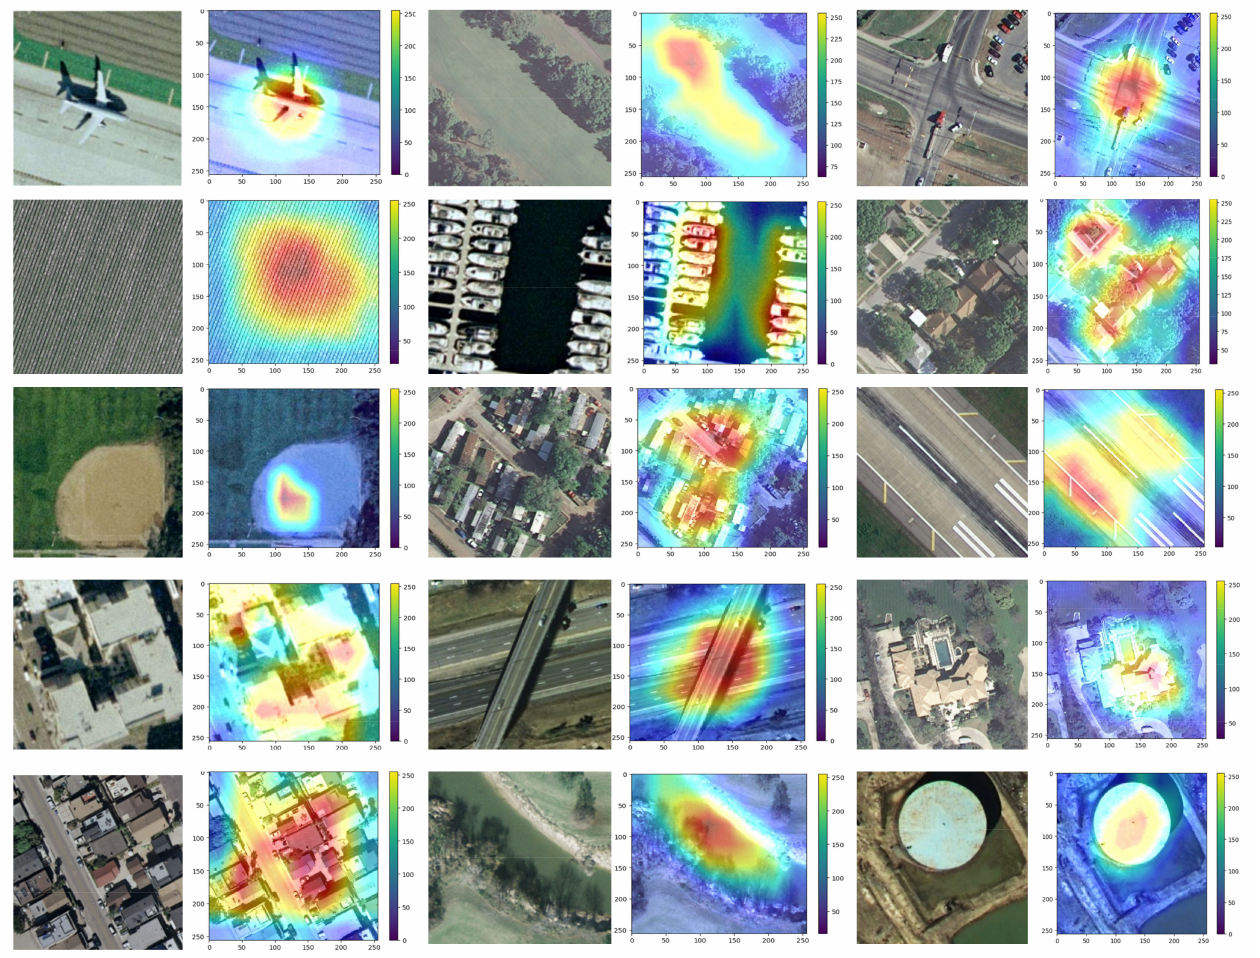
Figure 12. Cam visualization results of the LCNN-CMGF method on the UCM21